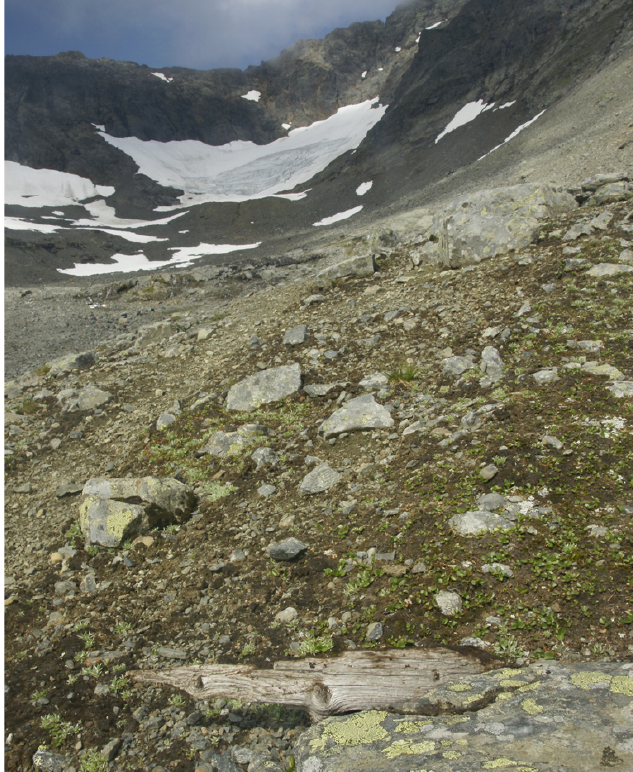
Figure 27: Helagsglaciären (1). Part of a birch stem preser- ved by outwash sediments in the lower part of the forefield. 7790 cal. yr BP (Beta-230895).